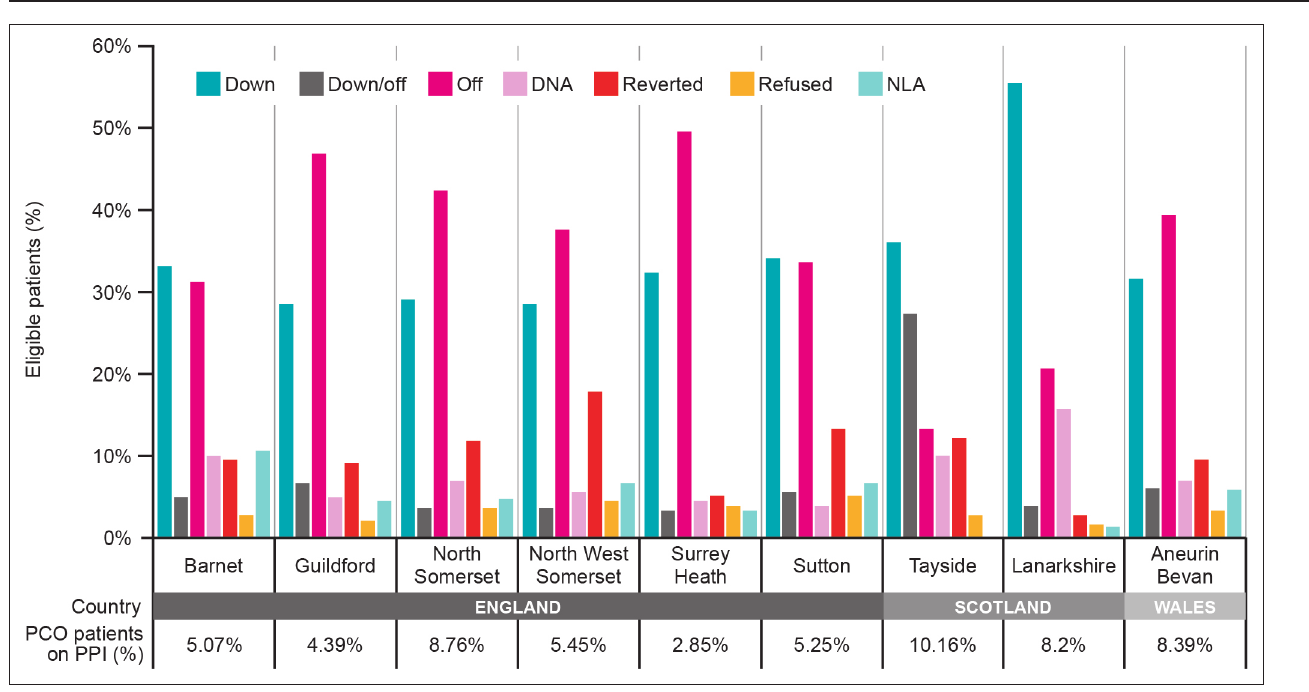
Figure 2 DTREP impact on PPI use across regional PCOs in England, Scotland, and Wales The proportion of PPI-treated patients and change in PPI status are summarised for each study PCO. DNA = did not attend. DTREP = Dyspepsia Therapy Review and Education Programme. NLA = no longer active. PCO = primary care organisation (clinical commissioning group). PPI = proton pump